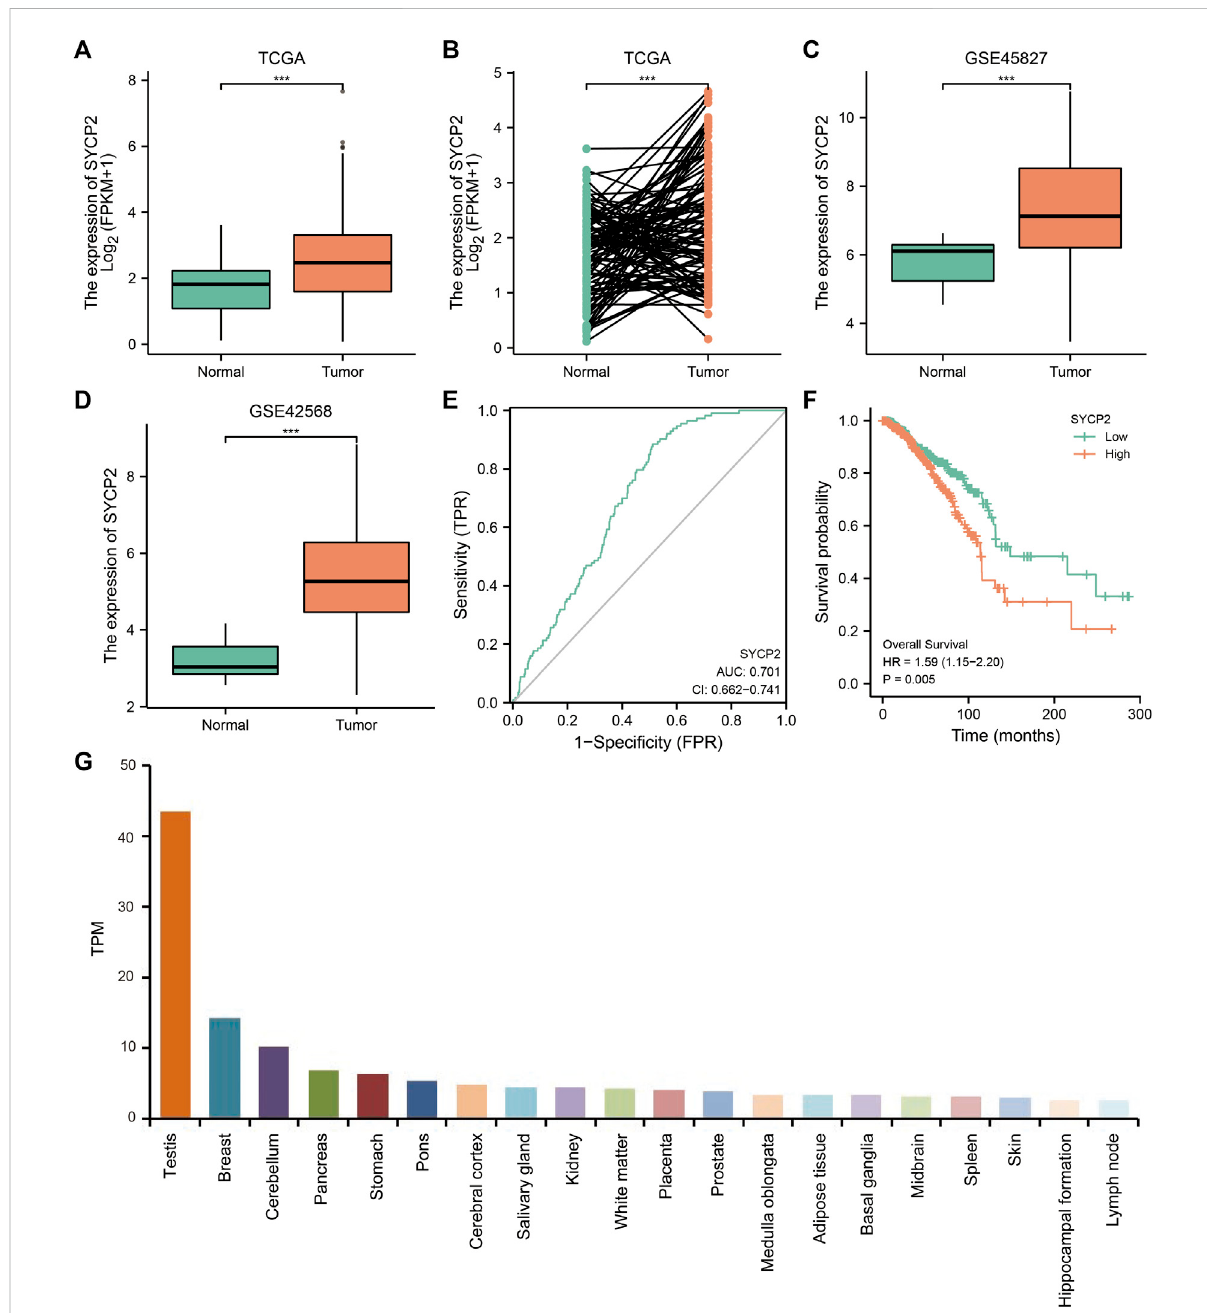
FIGURE 2 The mRNA and protein expression of SYCP2 in breast carcinoma. (A) The mRNA expression levels of SYCP2 within breast carcinoma and unpaired-adjacent tissues. (B) The mRNA expression levels of SYCP2 within 112 breast carcinoma and paired-adjacent tissues. (C) The mRNA expression levels of SYCP2 in the GSE45827 dataset. (D) The mRNA expression levels of SYCP2 in the GSE42568 dataset. (E) ROC curve revealed the ef fi ciency of the SYCP2 expression level in distinguishing breast carcinoma tissue from nontumor tissue. (F) Kaplan – Meier survival curve comparing the high and low expressionof SYCP2 inbreastcarcinoma. (G) Top 20distributionof SYCP2 in systemic tissue expression(ns, p ≥ 0.05; *, p < 0.05; **, p < 0.01; ***, p <